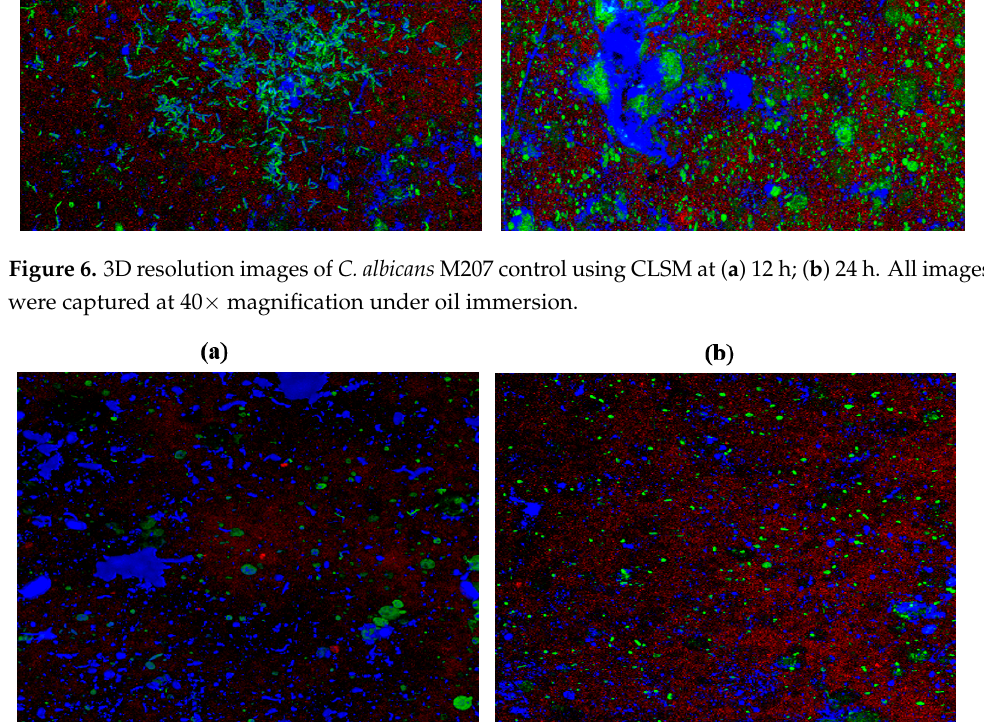
Figure 9. 3D resolution images of whole AGE ‐ treated (1.25 mg) E. coli ATCC 39936 using CLSM at ( a ) 12 h; ( b ) 24 h. All images were captured at 40× magnification under oil immersion.